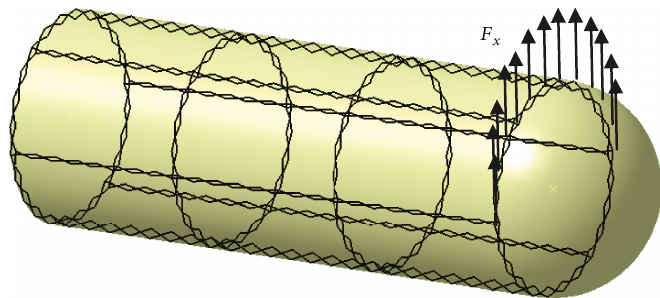
Figure 15: Nodal loads acted at each node.